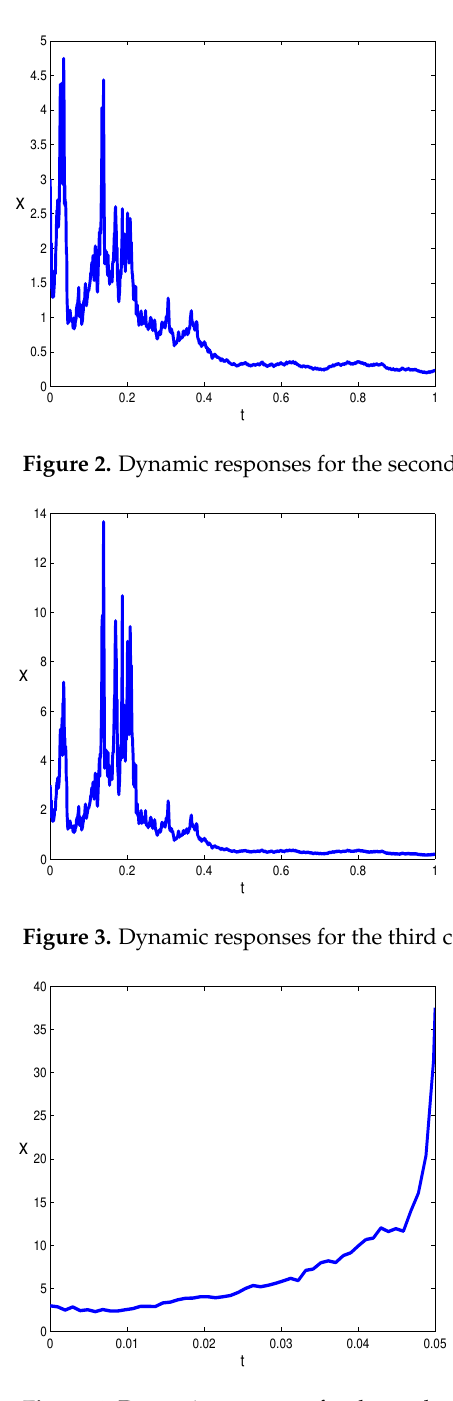
Figure 4. Dynamic responses for the explosive